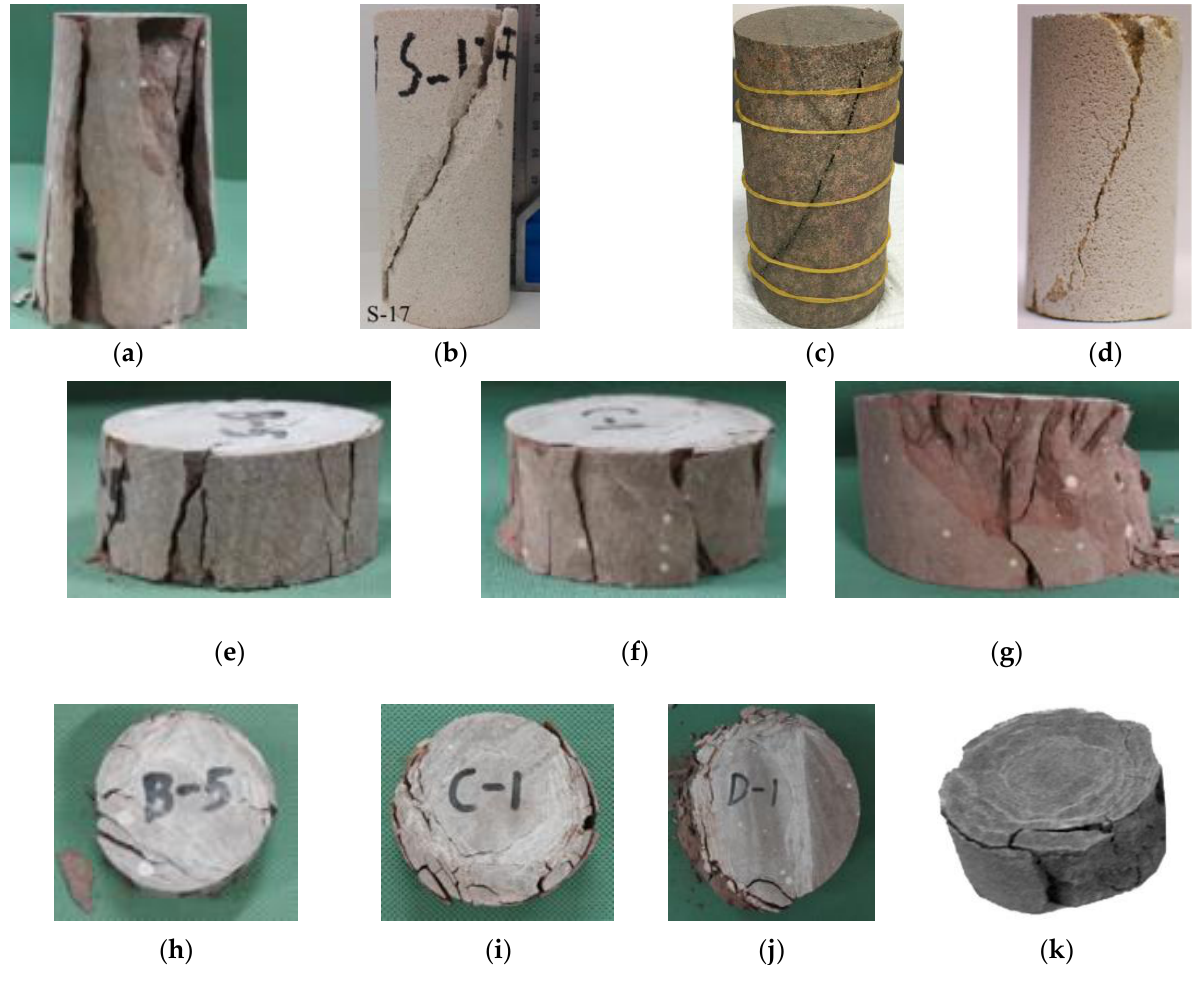
Figure 4. Failure patterns of sandstone . ( a ) Group A. ( b ) Vaneghi et al. [60]. ( c ) Li et al. [35]. ( d ) Wasantha et al. [62]. ( e ) Group B. ( f ) Group C. ( g ) Group D. ( h ) Cylindrical fracture of group B. ( i ) Cylindrical fracture of group C. ( j ) Cylindrical fracture of group D. ( k ) Fakhimi and Hemami [61].